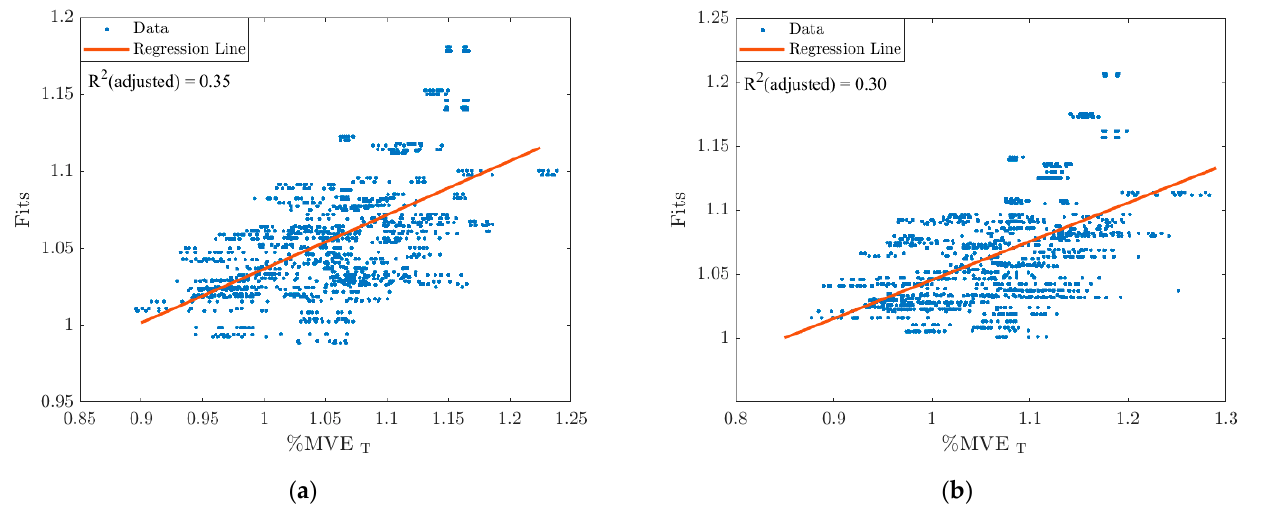
Figure 4. Fits vs. %MVE T (transformed % maximum voluntary electrical activation data) ( a ) before and ( b ) after back muscle fatigue from the stepwise regression models of the internal oblique (IO). Table 4. Stepwise regression models for %MVE T (transformed % maximum voluntary electrical activation data) of the internal oblique pre-and post-back muscle fatigue, where mass, height, and body mass index (BMI) are continuous pre- dictors, and vibration frequency is a categorical predictor.